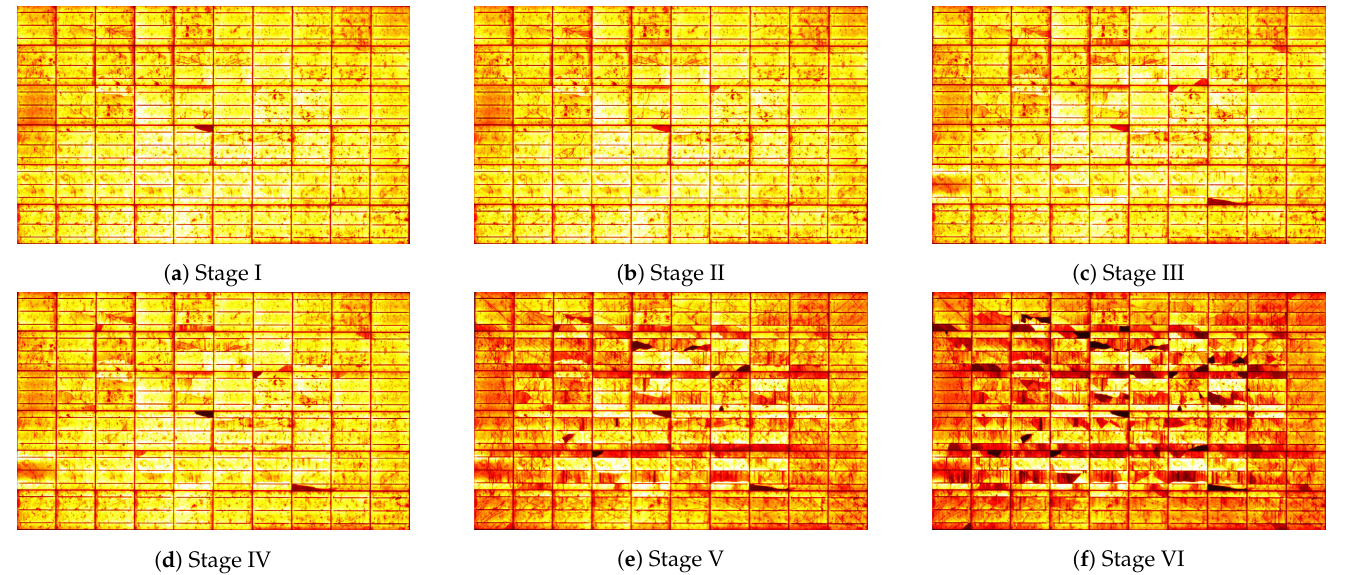
Figure 1. Electroluminescence (EL) images of module #1, measured at Standard Test Conditions (STC) I sc current bias, before the accelerated stress test (Stage I), and after each stress stage described in Table 1. Brighter image areas correspond to cell regions with higher luminescence, whereas darker areas correspond to low or no luminescence